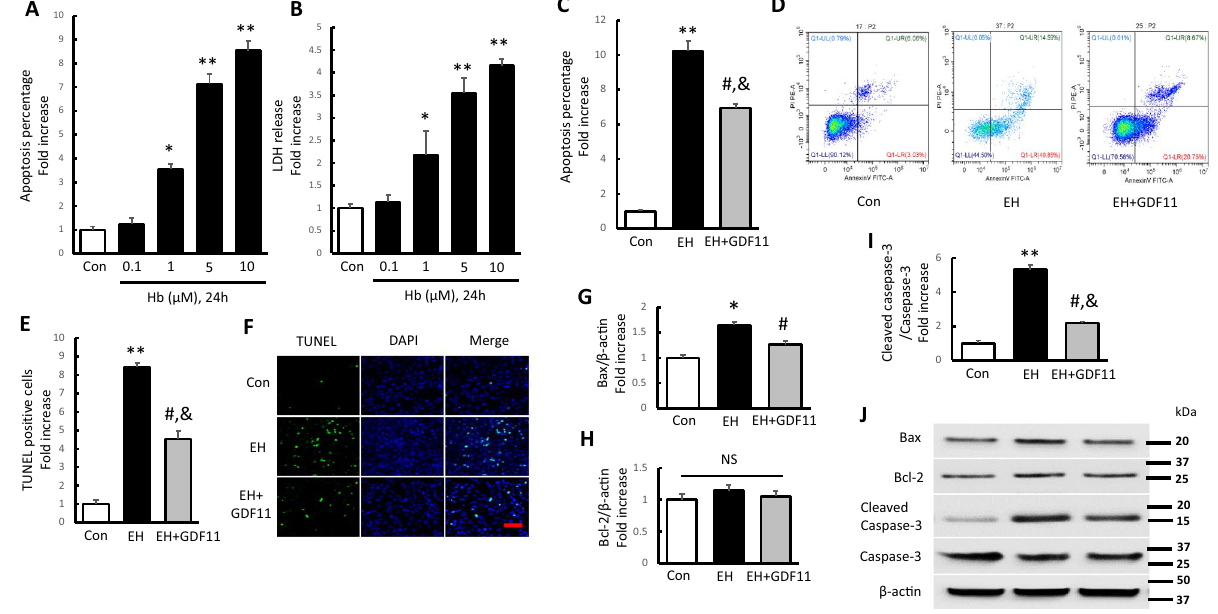
Figure 3. GDF11 attenuated EH-induced apoptosis and ROS accumulation in SH-SY5Y cells. ( A , B ) Quantification of apoptosis and cell released LDH in culture exposed to 0.1–10 μM Hb for 24 h. (Values shown as mean ± SD. *p < 0.05 and **p < 0.01 versus control group, n = 3). The cell cultures for EH treatment of the following experiments were exposed to 5 μM Hb environment for 24 h. ( C , D ) Bar graph and Flow cytometric quantification of apoptosis percentage presenting as fold increase (n = 7). ( E , F ) The TUNEL-positive cells presenting as fold increases and representative pictures for TUNEL/DAPI-fluorescence staining (scale bar 200 μm). ( G - J ) Quantification of immunoreactive bands for Bax ( G ), and Bcl-2 ( H ) relative to β-actin, and cleaved Caspase-3 ( I ) relative to Caspase-3. Immunoreactive bands for Bax, Bcl-2, cleaved Caspase-3, and Caspase-3 in the different group ( J ). Values shown as mean ± SD. *p < 0.05 and **p < 0.01 versus control group; # p < 0.05 versus EH group and & p < 0.05 versus control group (n = 7).